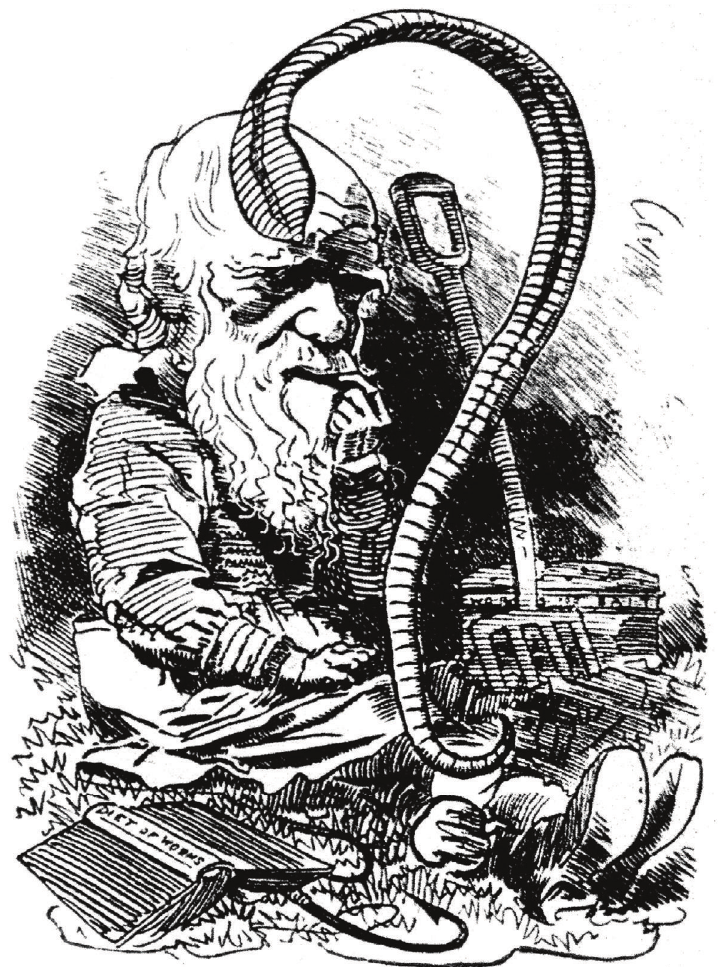
Figure 1: Charles Darwin as an earthworm scientist: caricature from the journal Punch , published in the year 1882.